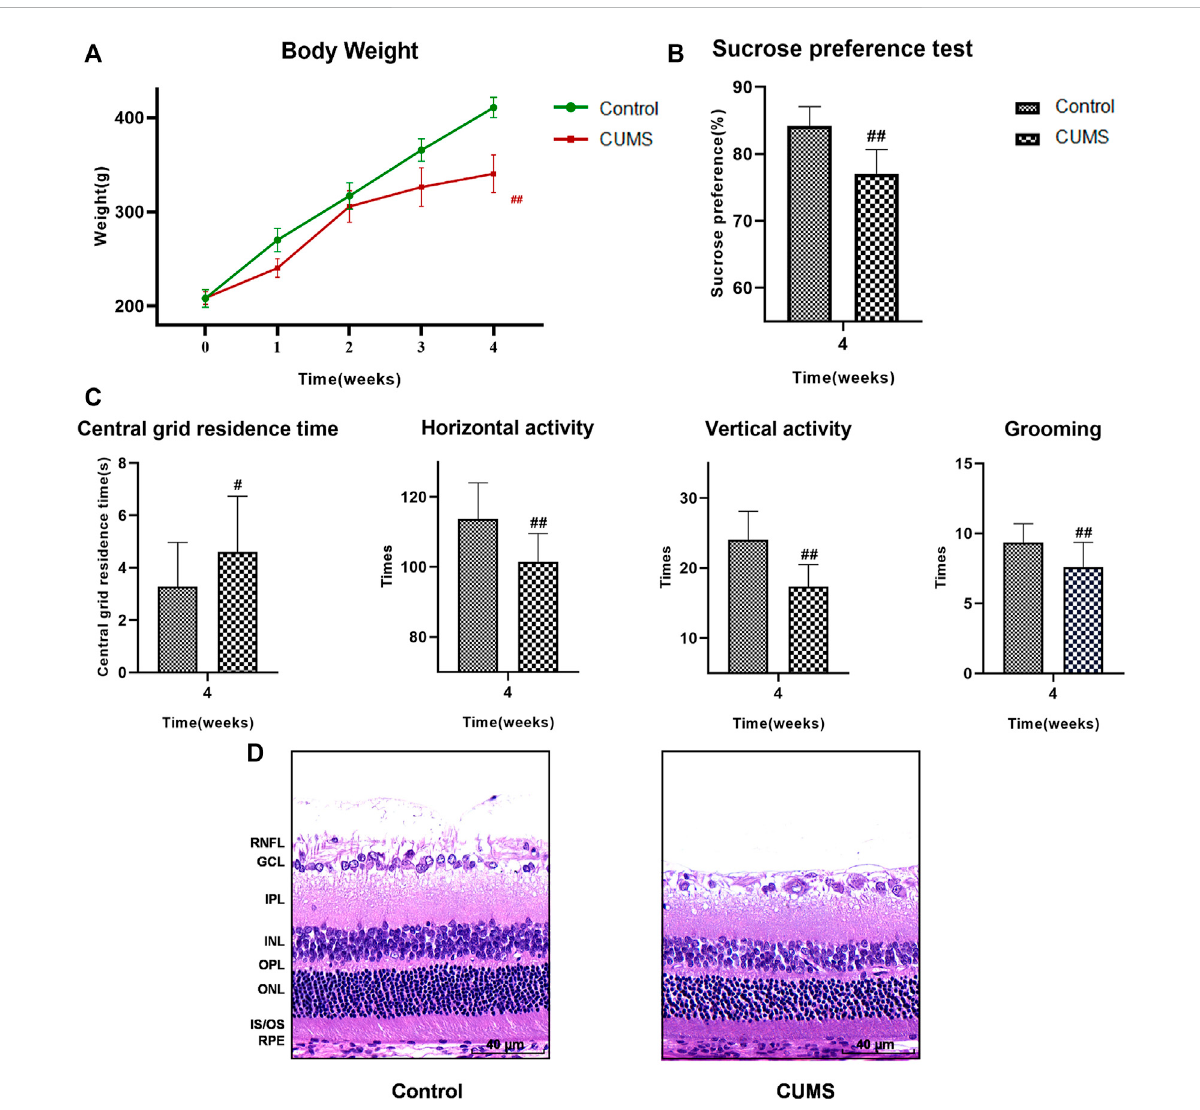
FIGURE 3 At 4 weeks, the results of weight, SPT, OFT and HE staining of the rats in the control group and CUMS group. (A) Weight trend of rats in the two groups. (B) Results of SPT. (C) Results of OFT, including the central grid residence time, horizontal activity, vertical activity and grooming times. (Controlgroupn=14,CUMSgroupn=38).Resultsareshownasthemean±SD. # p < 0.05and ## p < 0.01vs.controlgroup. (D) HEstainingofretinain the two groups. Scale bar = 40 µm. In the CUMS group, the full retina was thinner; the nucleus of RGC was pyknotic and the number of RGC decreased; the INL and ONL were loose and irregular. RNFL, retinal nerve fi ber layer; GCL, ganglion cell layer; RGC, retinal ganglion cell; IPL, inner plexiform layer; INL, inner nuclear layer; OPL, outer plexiform layer; ONL, outer nuclear layer; IS/OS, the inner and outer segments of photoreceptors; RPE, retinal pigmented